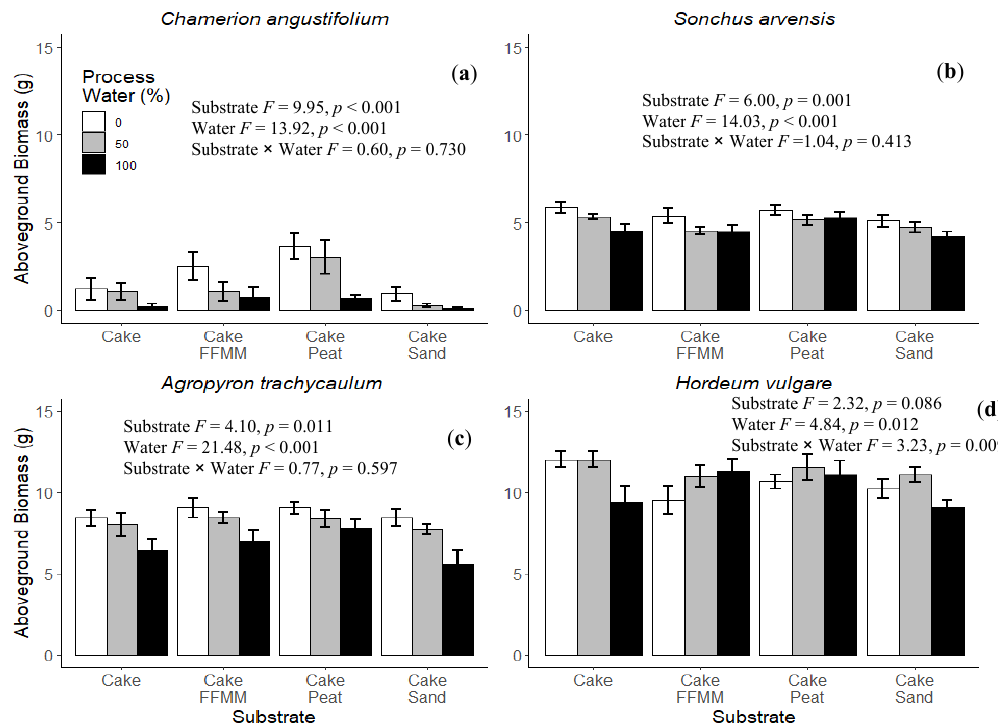
Figure 1. Total aboveground biomass (mean and standard error) of four understory species ( a ). Chamerion angustifolium ; ( b ). Sonchus arvensis ; ( c ). Agroypyron trachycaulum ; ( d ) Hordeum vulgare , commonly found in newly reclaimed areas in the boreal forest region of Canada, under four soil amendments and three watering treatments.